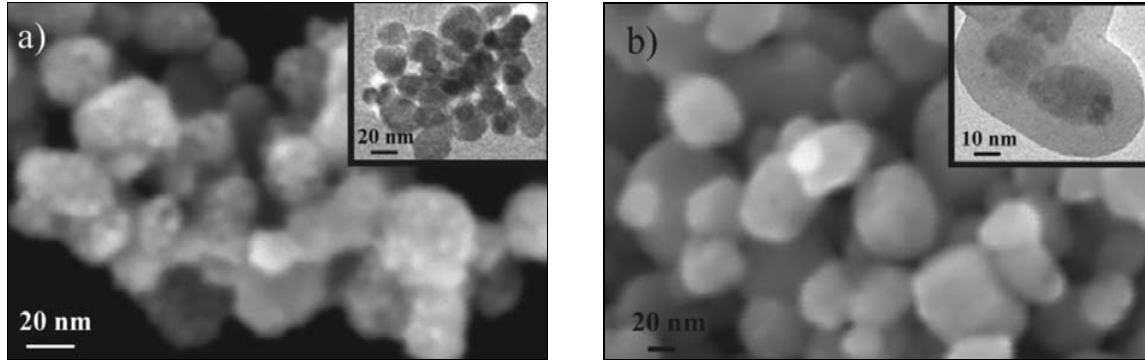
Figure 2. SEM and TEM micrographs of a) bare ZnO and b) silica-coated spherical ZnO nanoparticles